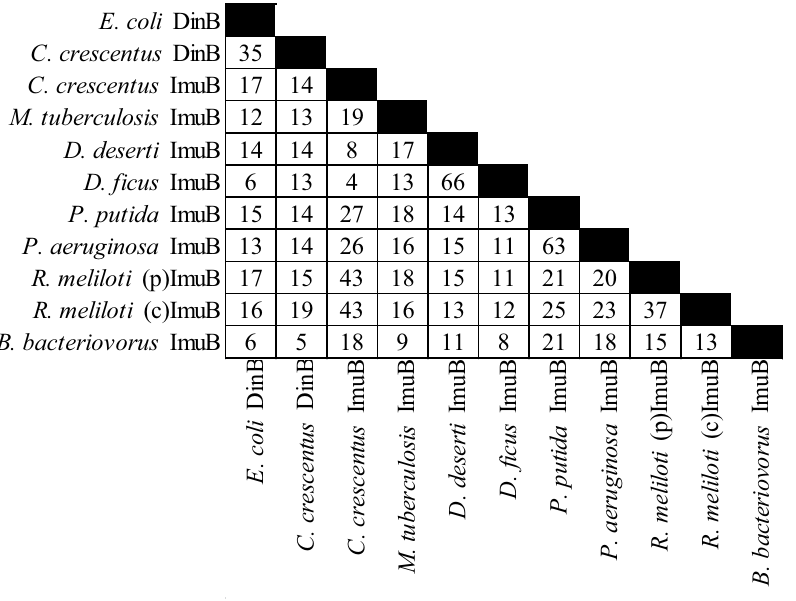
Figure 3. Percent identities by ClustalW2 [213,214] for ImuB protein and related proteins. (cid:179)(cid:11)(cid:83)(cid:12)(cid:180)(cid:3)(cid:85)(cid:72)(cid:83)(cid:85)(cid:72)(cid:86)(cid:72)(cid:81)(cid:87)(cid:86)(cid:3)(cid:87)(cid:75)(cid:72)(cid:3)(cid:83)(cid:79)(cid:68)(cid:86)(cid:80)(cid:76)(cid:71)(cid:3)(cid:74)(cid:72)(cid:81)(cid:72) (cid:83)(cid:85)(cid:82)(cid:71)(cid:88)(cid:70)(cid:87)(cid:15)(cid:3)(cid:179)(cid:11)(cid:70)(cid:12)(cid:180)(cid:3)(cid:85)(cid:72)(cid:83)(cid:85)(cid:72)(cid:86)(cid:72)(cid:81)(cid:87)(cid:86)(cid:3)(cid:87)(cid:75)(cid:72)(cid:3)(cid:70)(cid:75)(cid:85)(cid:82)(cid:80)(cid:82)(cid:86)(cid:82)(cid:80)(cid:68)(cid:79)(cid:3)(cid:74)(cid:72)(cid:81)(cid:72)(cid:3)(cid:83)(cid:85)(cid:82)(cid:71)(cid:88)(cid:70)(cid:87)(cid:17)(cid:3) The accessions are from Uniprot [215] with the exception of D. ficus ImuB from RefSeq [216], from left to right: Q47155, Q9A5I1, B8H428, O50419, C1D2K9, ADO33718, Q88I83, Q9I5Q1, Q92ZJ7, Q92JS7, Q6MQS5.